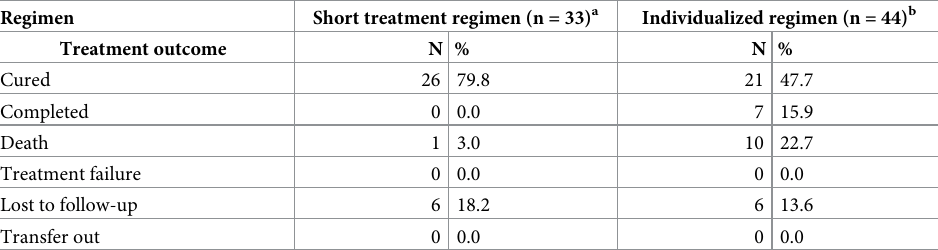
Table 6. Treatment outcome (n = 77).